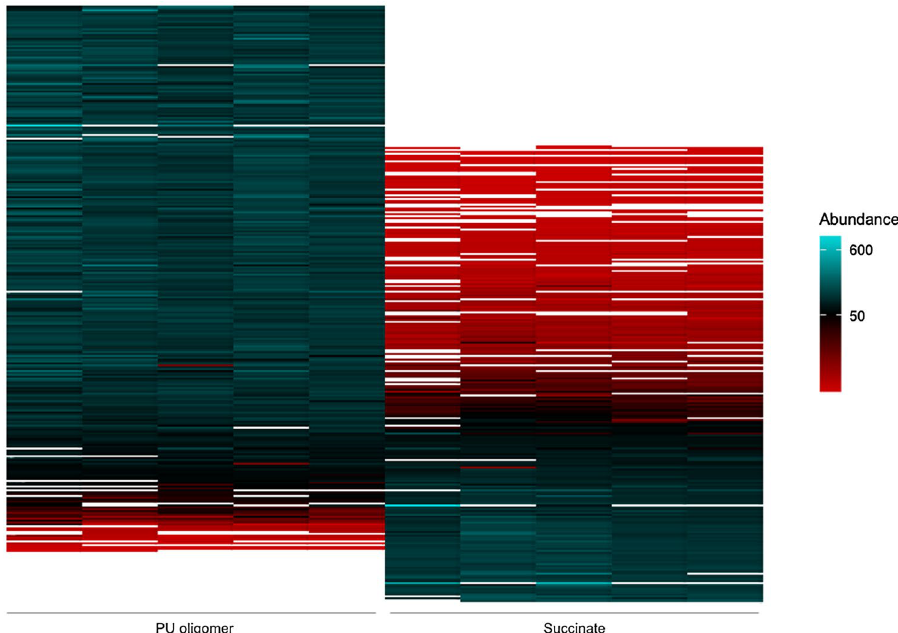
Figure 4. Heatmap of extracellular proteins detected by mass spectrometry on OMV fractions of TDA1 in PU oligomer or succinate showing the difference of the samples. Abundance for each of the five replicates of each treatment is given as a color scale, being white non detected enzymes.